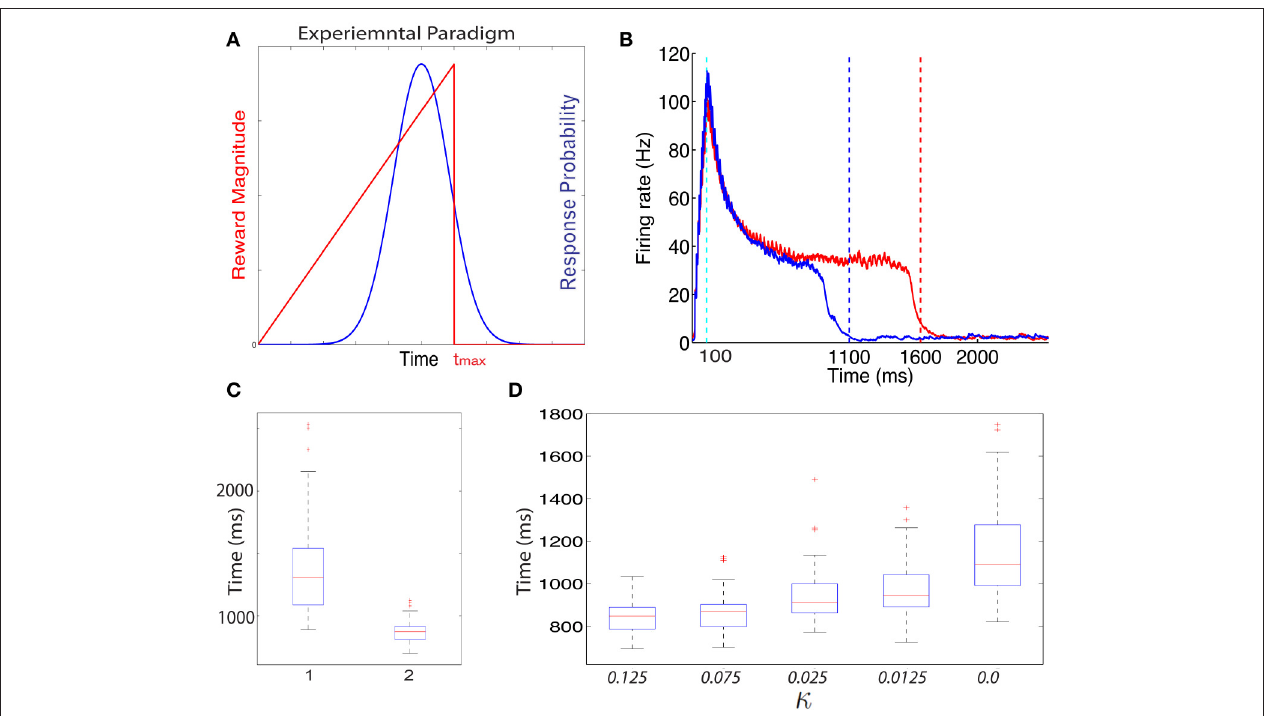
FIGURE 4 | Training with a ramp reward paradigm. (A) In the ramp reward paradigm, the animal gets a reward that depends on the timing of its action. The magnitude of reward increases linearly with the timing of action, until a maximal time t max after which no reward is obtained (red line). Rodents trained with this paradigm ( Namboodiri et al., 2015) act close to the time t max is a way that is nearly optimal given the temporal distribution of action times. A schematic depiction of the temporal distribution of action is shown by the blue curve. As observed experimentally, the peak of the response times is located slightly below T max . (B) Excitatory cells in a network trained with a ramp that terminates at T max = 1500 ms exhibit sustained activity that terminates close to 1500ms. A typical response is shown in red. When the paradigm is altered such that t max = 1000 ms the neural response adapts and terminates close to 1000 ms (typical response in blue). (C) The neural response varies from trial to trial. A box-plot (median and quartiles) summarizes the statistics of threshold crossing for networks trained to 1500 ms (1) and 1000 ms (2). (D) The distribution of response times depends on the value of the parameter κ that determines the amount of R 2 when no reward is